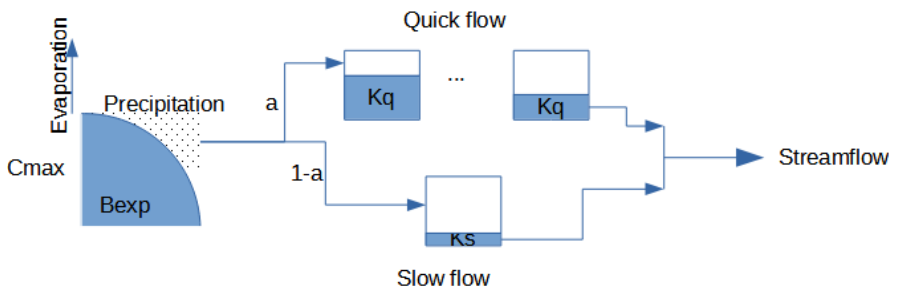
Figure 1. Schematic representation of the HYMOD model.